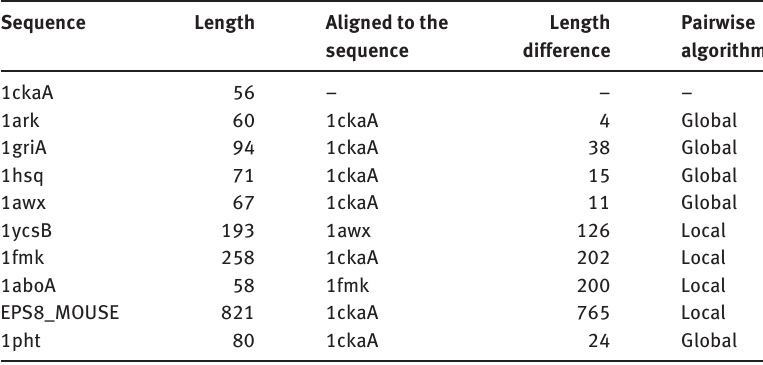
Table 1. The Progression of the Sequence Alignments. Sequence Length Aligned to the